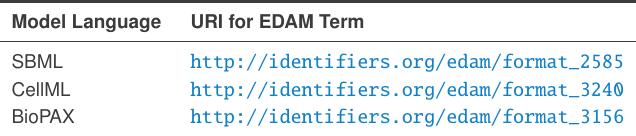
Table 8: Terms from the EDAM ontology to specify the language property of a Model .